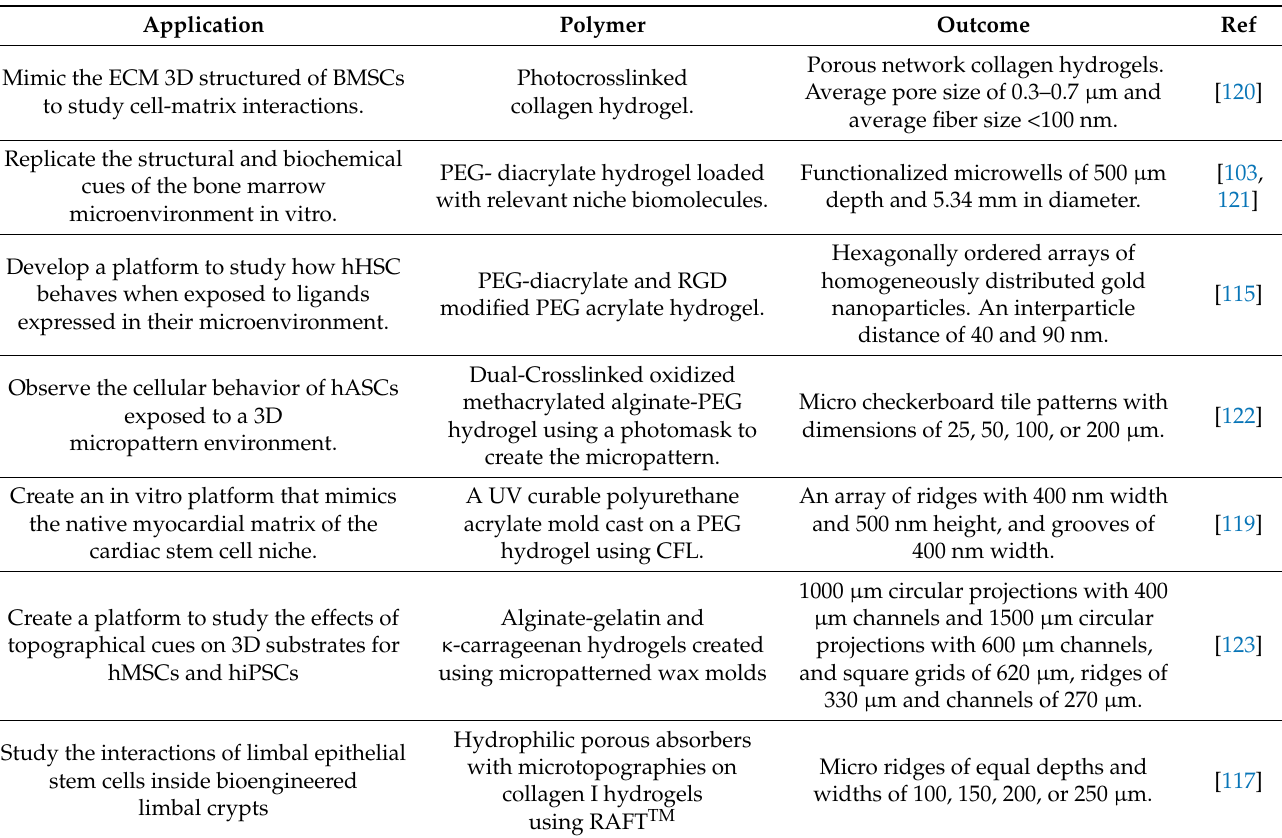
Table 3. Summary of pattern hydrogel constructs used to recreate the micro and nano spatial cues of the stem cell niche. Application Polymer Outcome Ref Mimic the ECM 3D structured of BMSCs Photocrosslinked to study cell-matrix interactions. collagen hydrogel. PEG- diacrylate hydrogel loaded with relevant niche